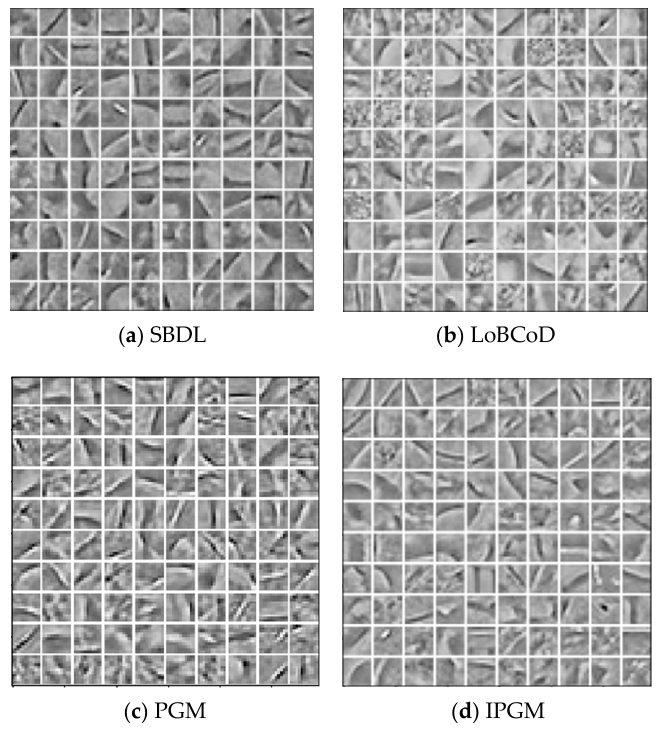
ral fruit images. ( a – d ) is the dictionary obtained by SBDL, LOBCOD, PGM, IPGM, respectively.